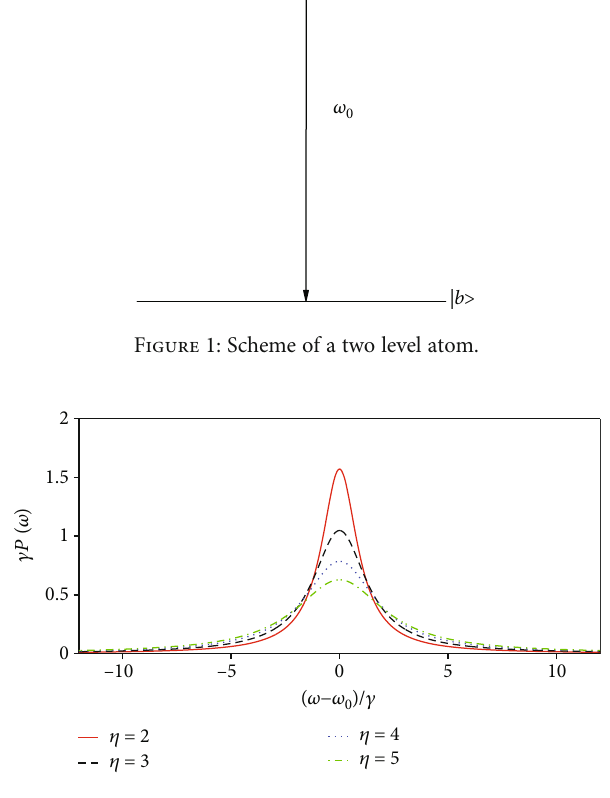
Figure 4: Plots of the second-order correlation function versus γτ for di ff erent values of η .